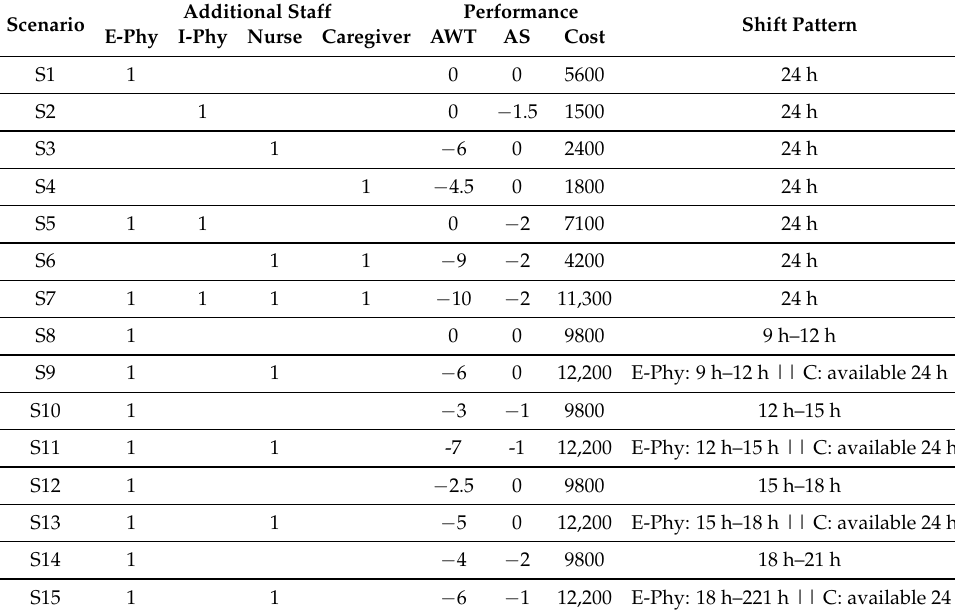
Table A2. Proposed scenarios of Category 1 and their decision matrices (long